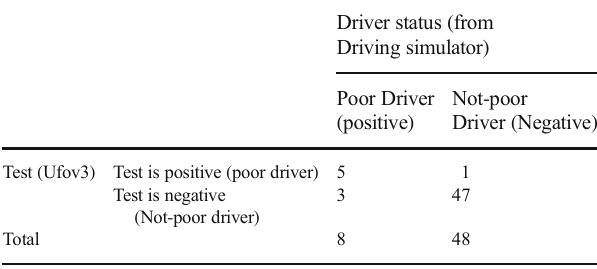
The Sensitivity, Specificity, Positive Predictive Value, Negative Predictive Value and Correct Classification of the UFOV3 test